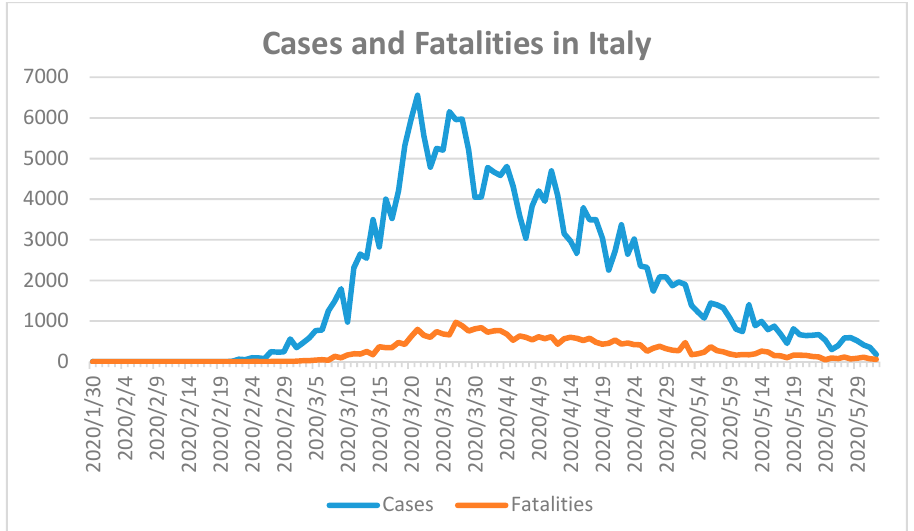
Figure 4. Fatalities during COVID-19 in Italy until 2 June 2020 [18]. First confirmed case in Italy on 31